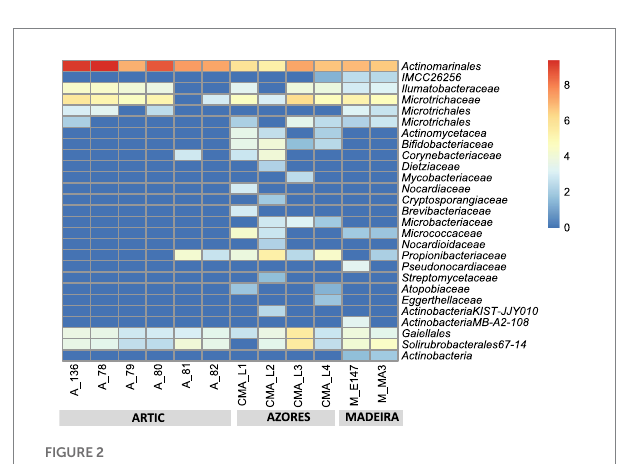
FIGURE 2 Heatmap with log transformation of the ASV abundance of Actinobacteria at order and family taxonomic levels in all deep-sea